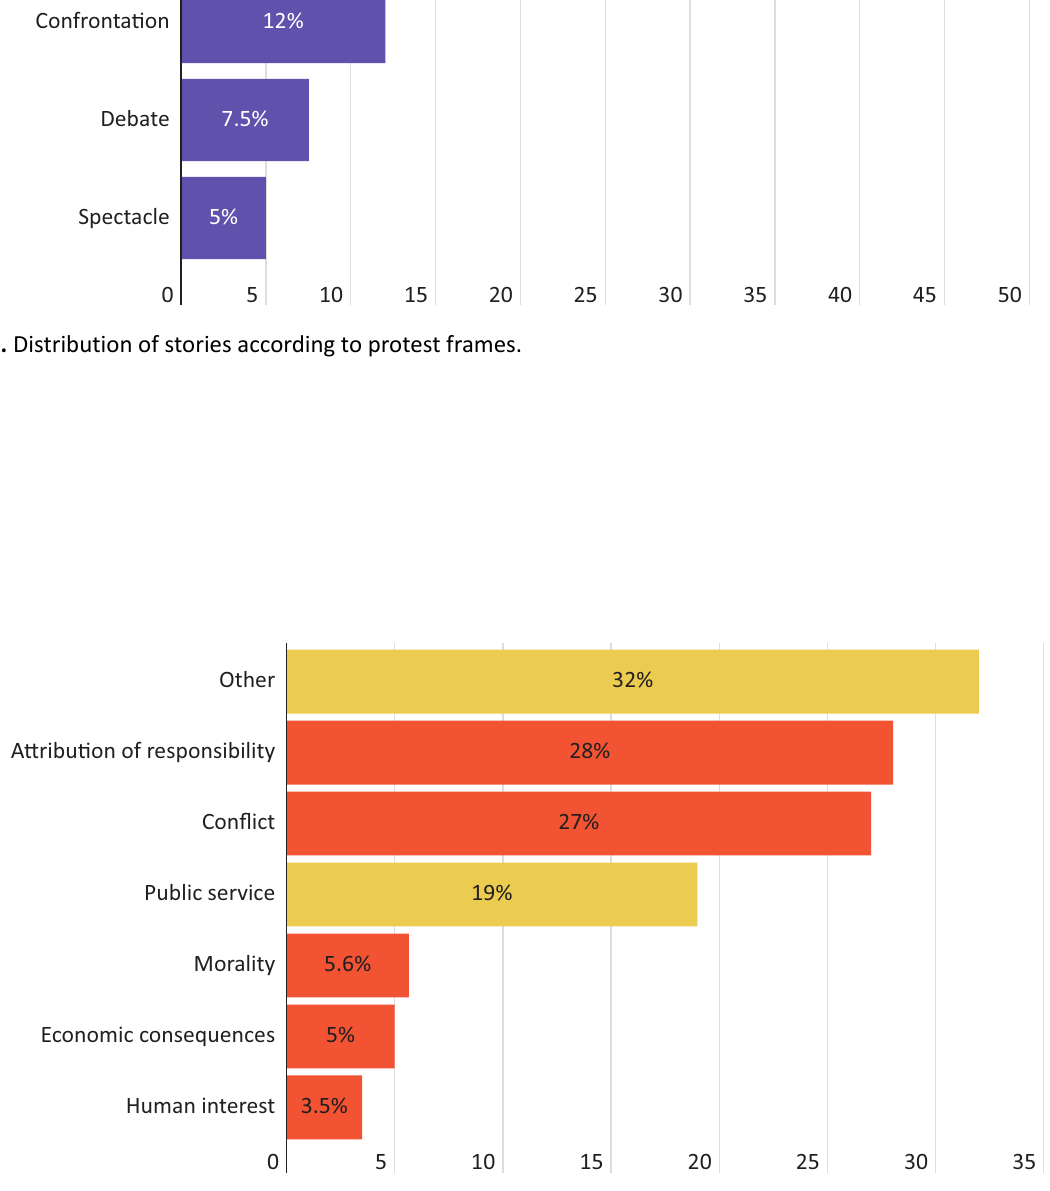
Figure 2. Distribution of stories according to generic frames. Note: Percentages add up to more than 100% as a story might present more than one